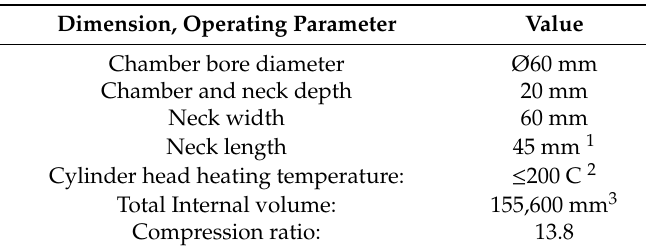
Table 2. Cylinder head data (current “Car” configuration).